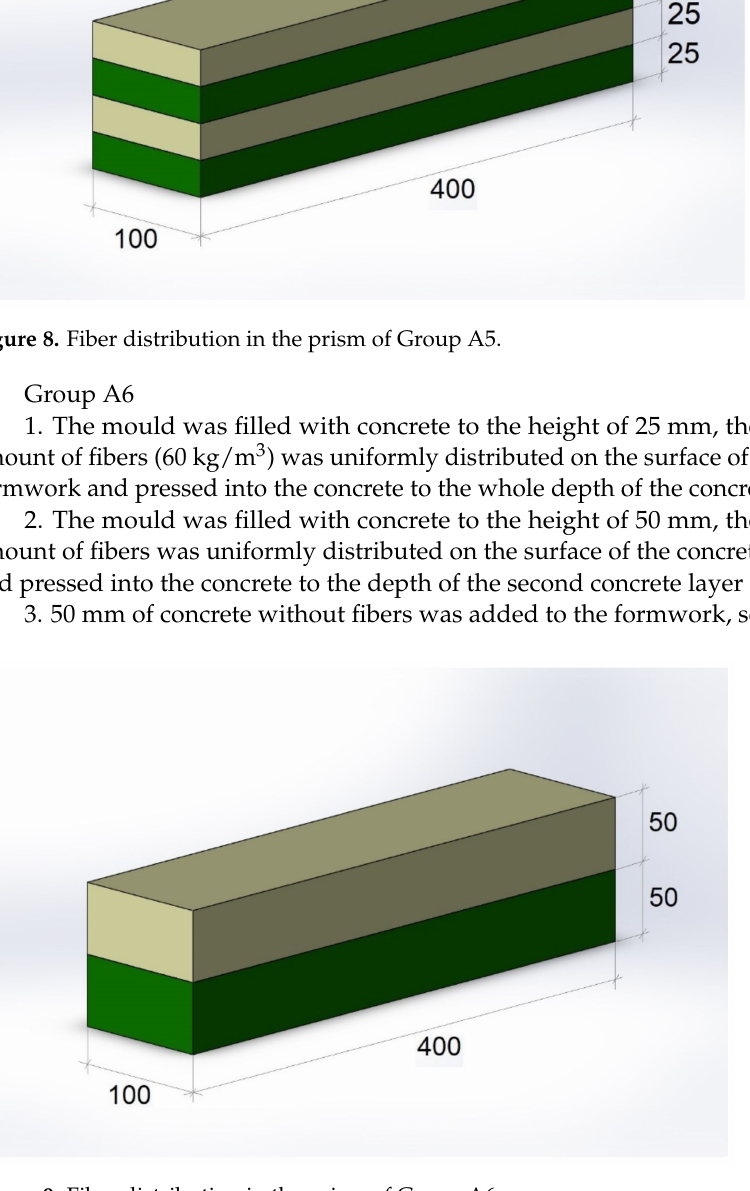
Figure 9. Fiber distribution in the prism of Group